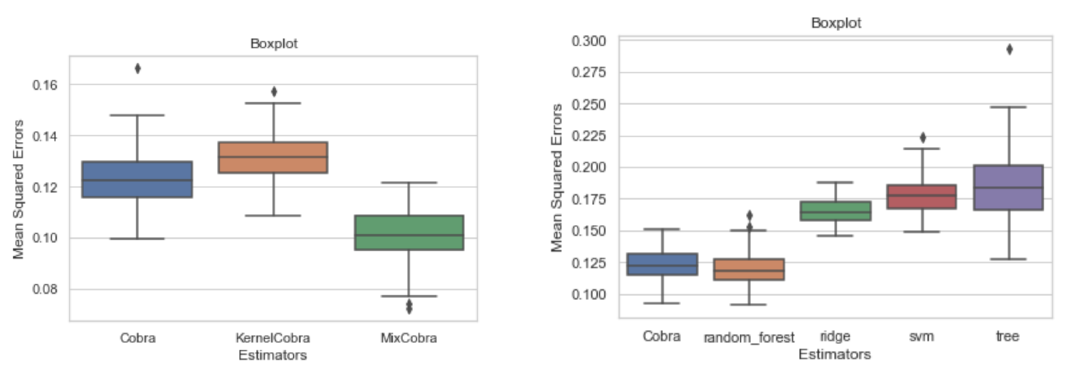
Figure 2. Boxplot of errors over 100 independent runs.